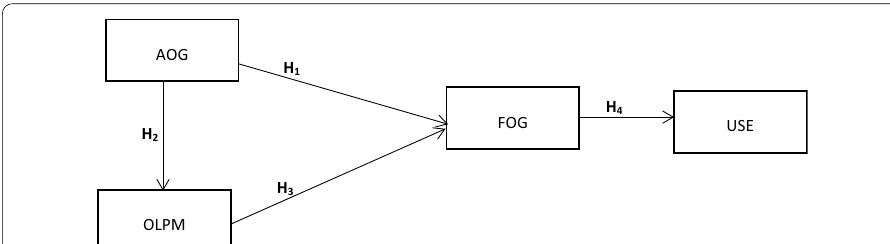
Fig. 1 Conceptual framework highlighting the dependent and independent variables of the study. AOG Availability of Gadgets; FOG Functionality of gadgets; OLPM Online teaching/presentation methods; USE Use of online learning